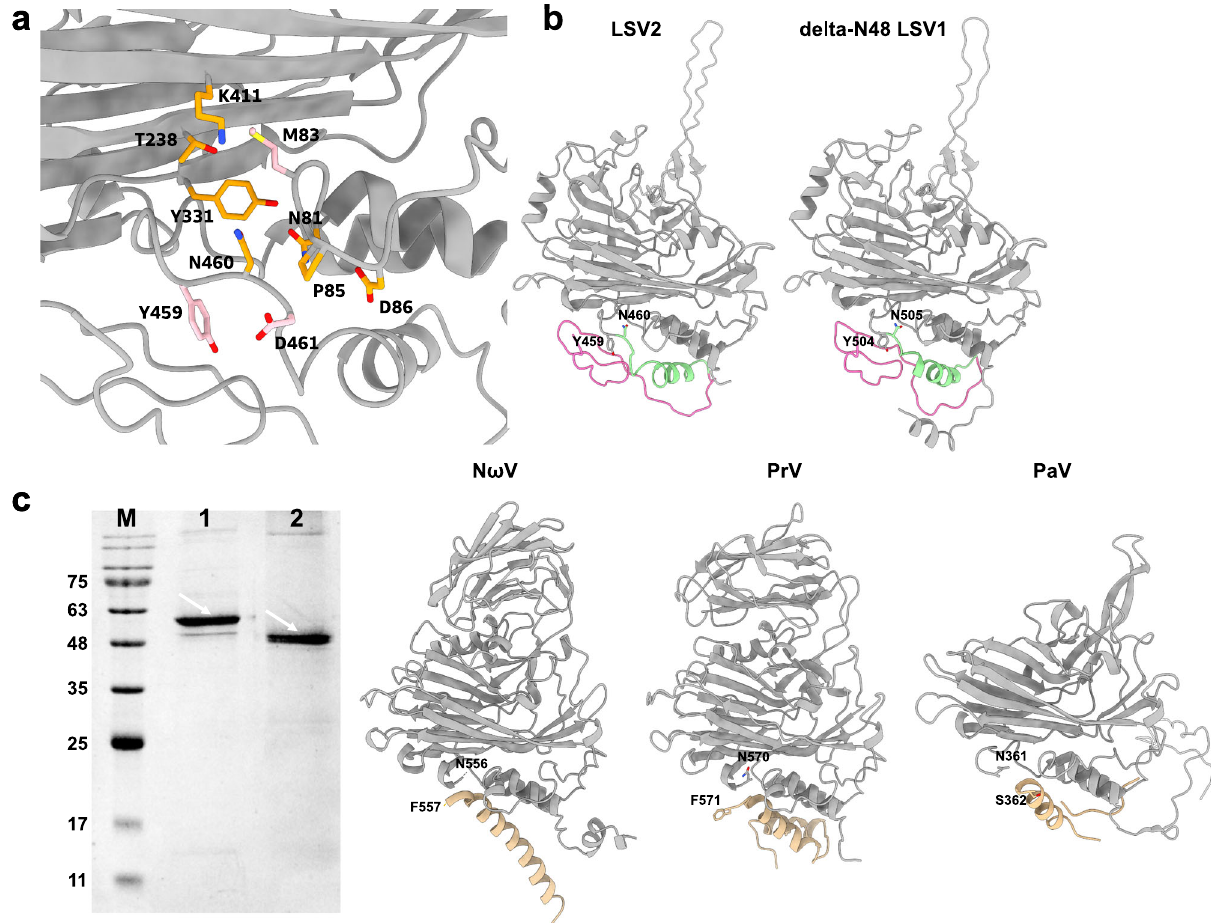
Fig. 4 | Structure comparison at the autoproteolysis cleavage area. a The mimicking autoproteolysis site (gray ribbon) in LSV2 CP contains identical key residues (orange sticks) except the key catalytic residues M83, Y459, and D461 (pink sticks), compared to other tetraviruses with γ peptide cleavage. b A com- parison of scissile bonds among LSV2, delta-N48 LSV1, N ω V (tetravirus), PrV (tet- ravirus), and PaV (alphanodavirus) CPs. The helix α 12 and C-arm of the LSV2 and